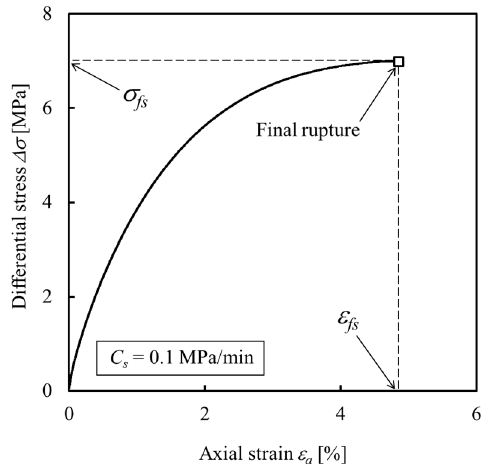
Figure 4. Differential stress Δ σ versus axial strain ε a in constant-stress-rate test [26].